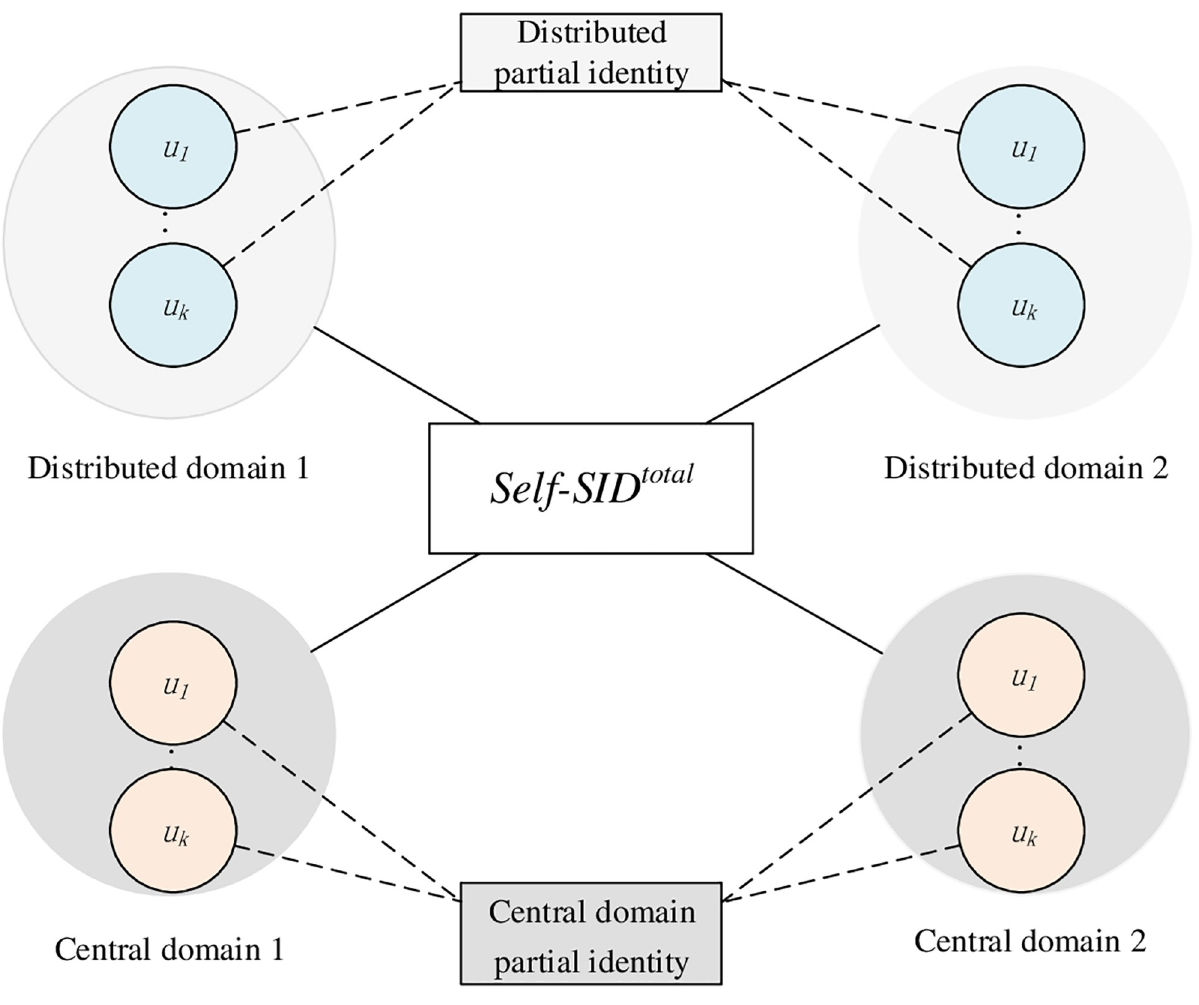
Fig 3. Self-sovereign